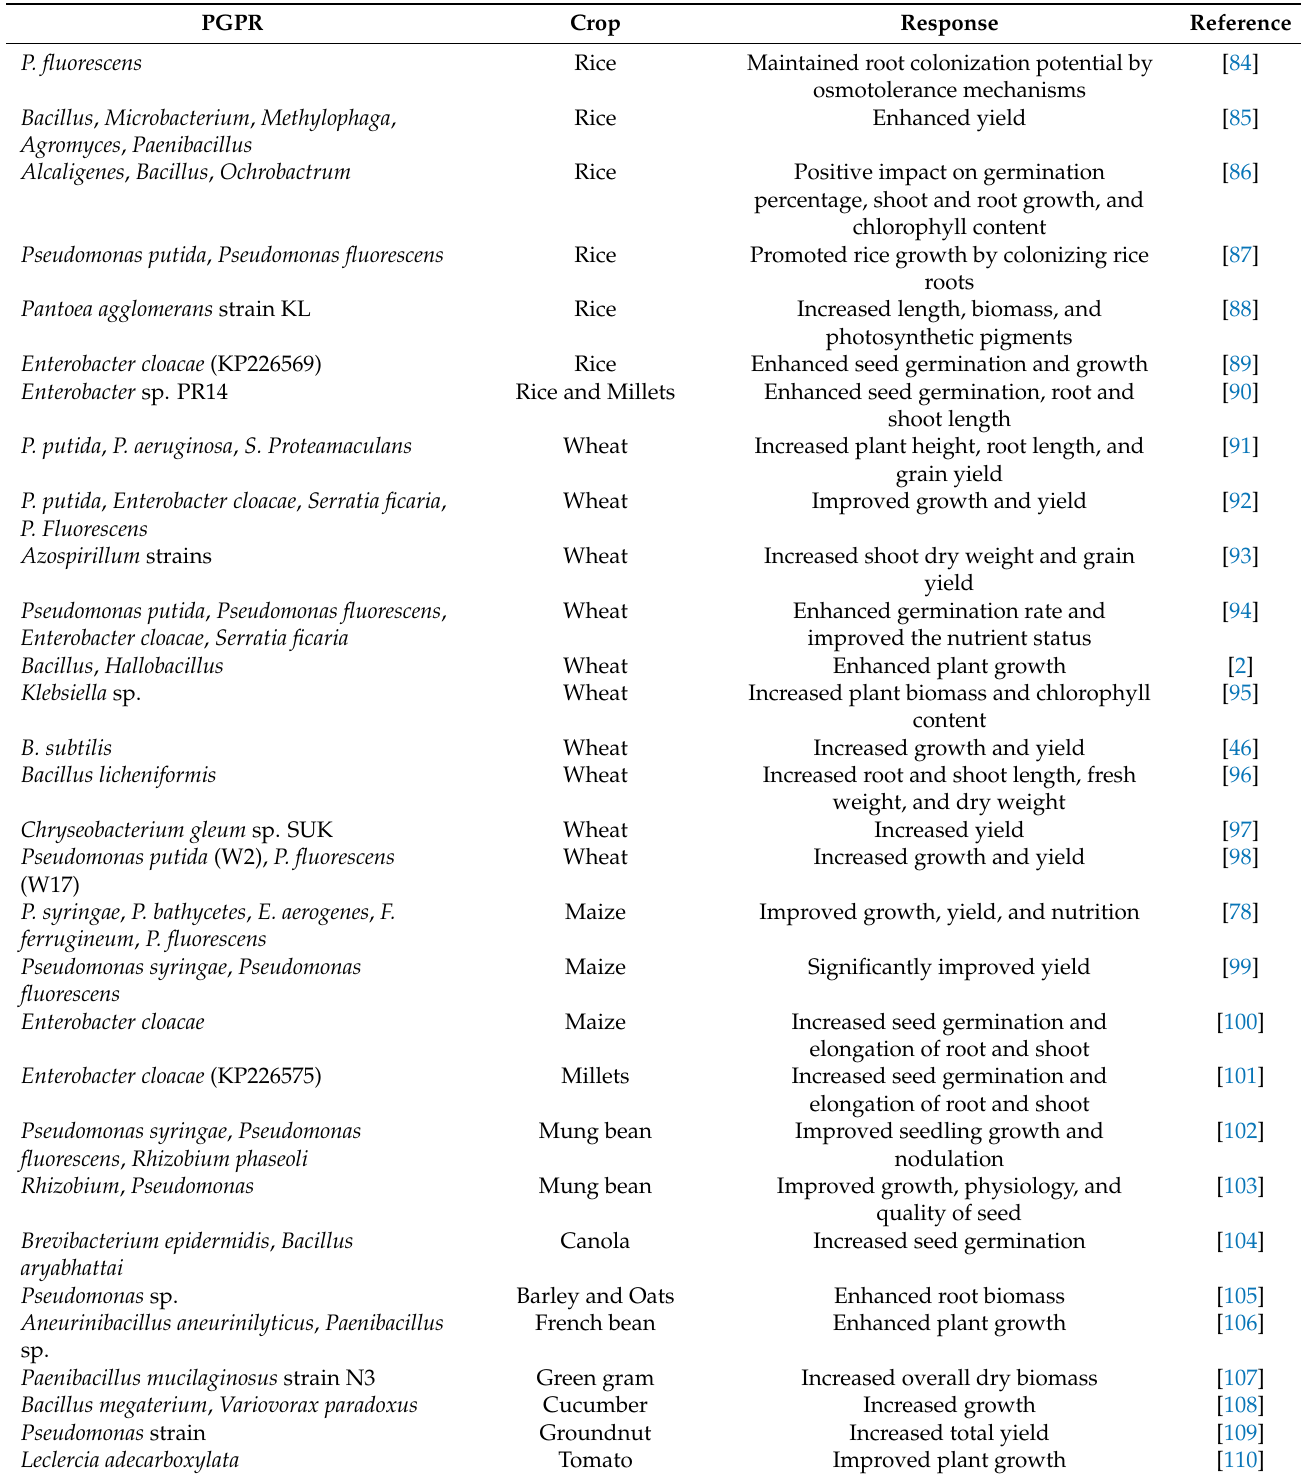
Table 2. Alleviation of the impact of salinity stress by PGPR with ACC-deaminase